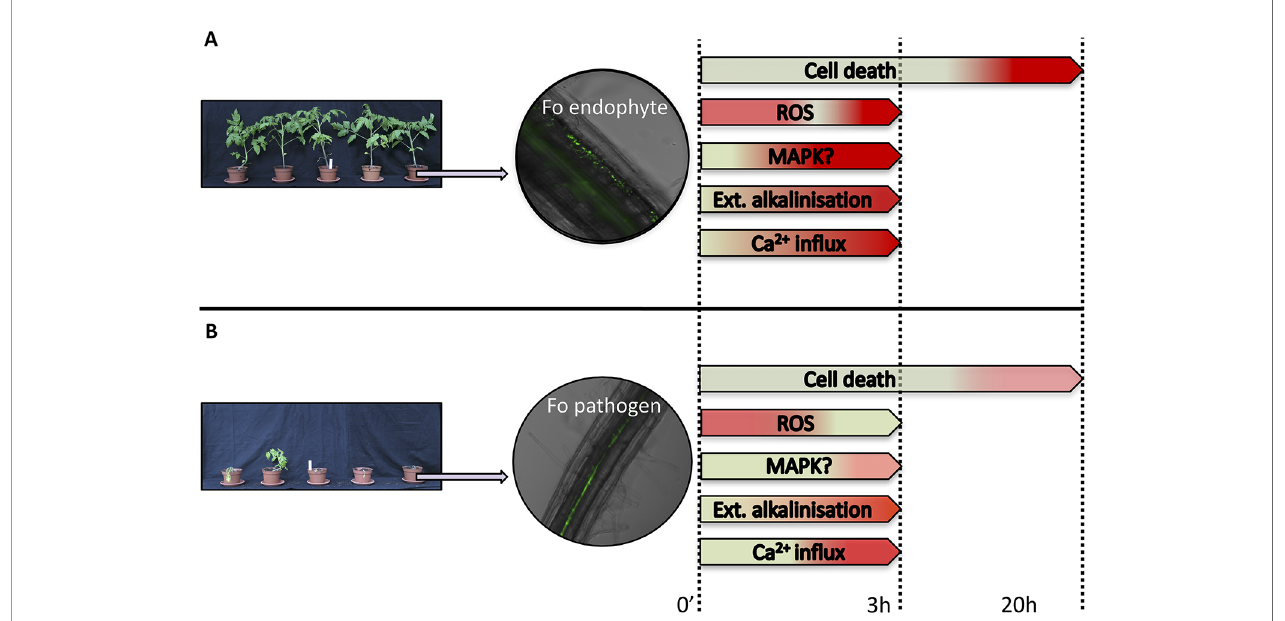
FIGURE 1 | Schematic representation of plant responses upon Fusarium oxysporum (Fo) inoculation. Responses of plants following exposure to a Fo endophyte (A) or a pathogen (B) . Pictures on the left show representative phenotypes of tomato plants upon inoculation with either an endophytic or a pathogenic Fo strain. Middle panels show root colonization by GFP-labeled Fo strains visualised by fl uorescence microscopy. The right panel summarizes early signaling responses upon Fo exposure to plant cell cultures (Olivain et al., 2003; Humbert et al., 2015). The response amplitudes are color-coded from green (lowest) to red